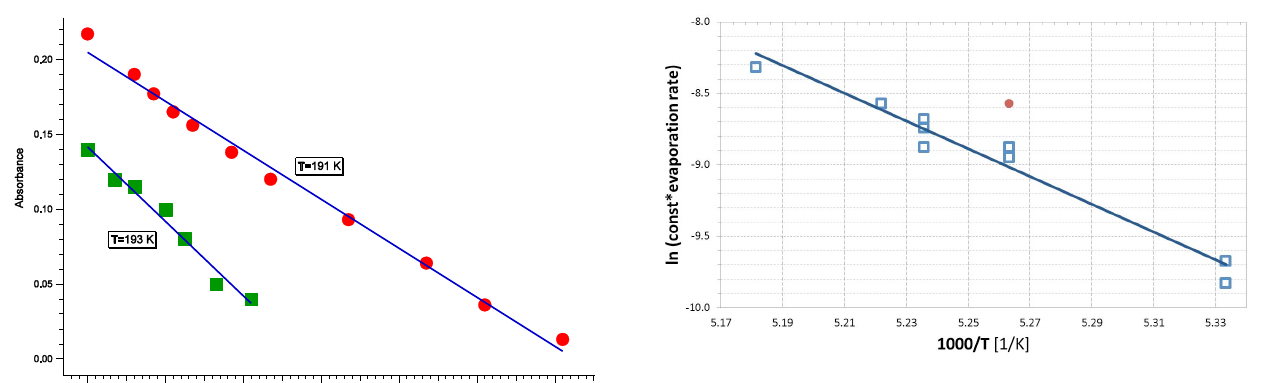
Fig. 4. Rate of decrease of IR absorbance at 3426cm − 1 of a pure q Figure 4. Rate of decrease of IR absorbance at 3426 cm -1 of a pure HCl•6H 2 O sample during HCl 6H 2 O sample during evaporation under SFR conditions at evaporation under SFR conditions at T = 191 and 193 ± 1 K, displayed as a function of time. See also T = 191 and 193 ± 1K displayed as a function of time. See also Figure 2. Fig. 2.